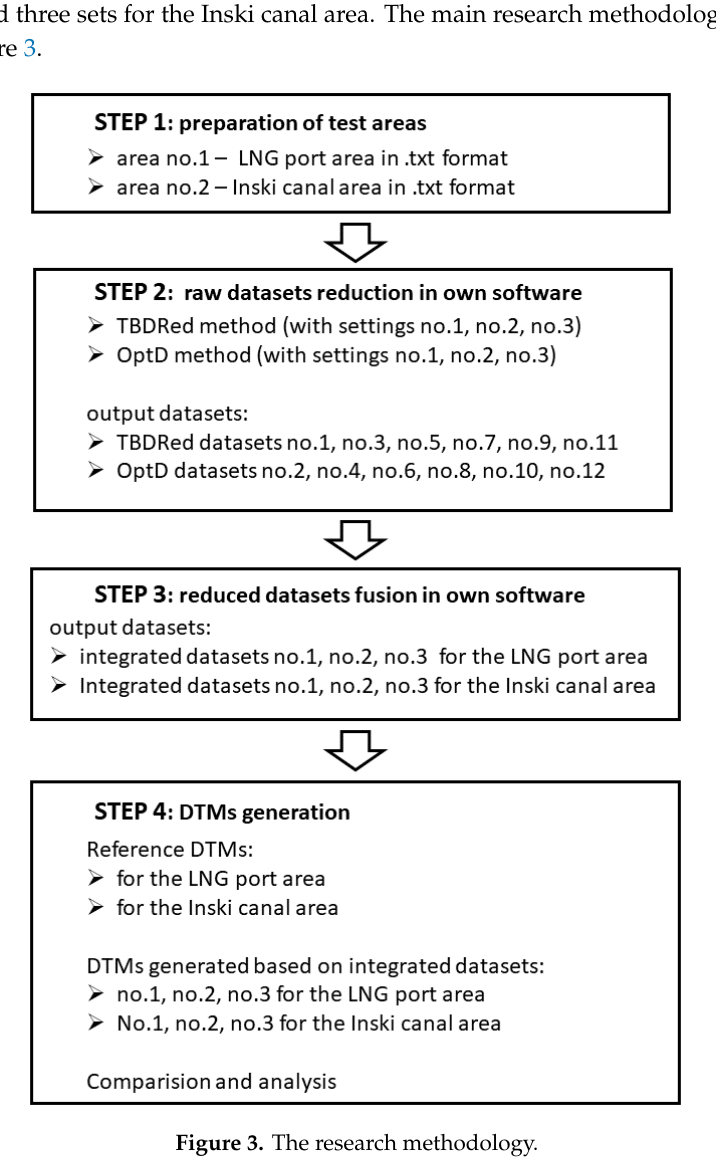
Figure 3. The research methodology.